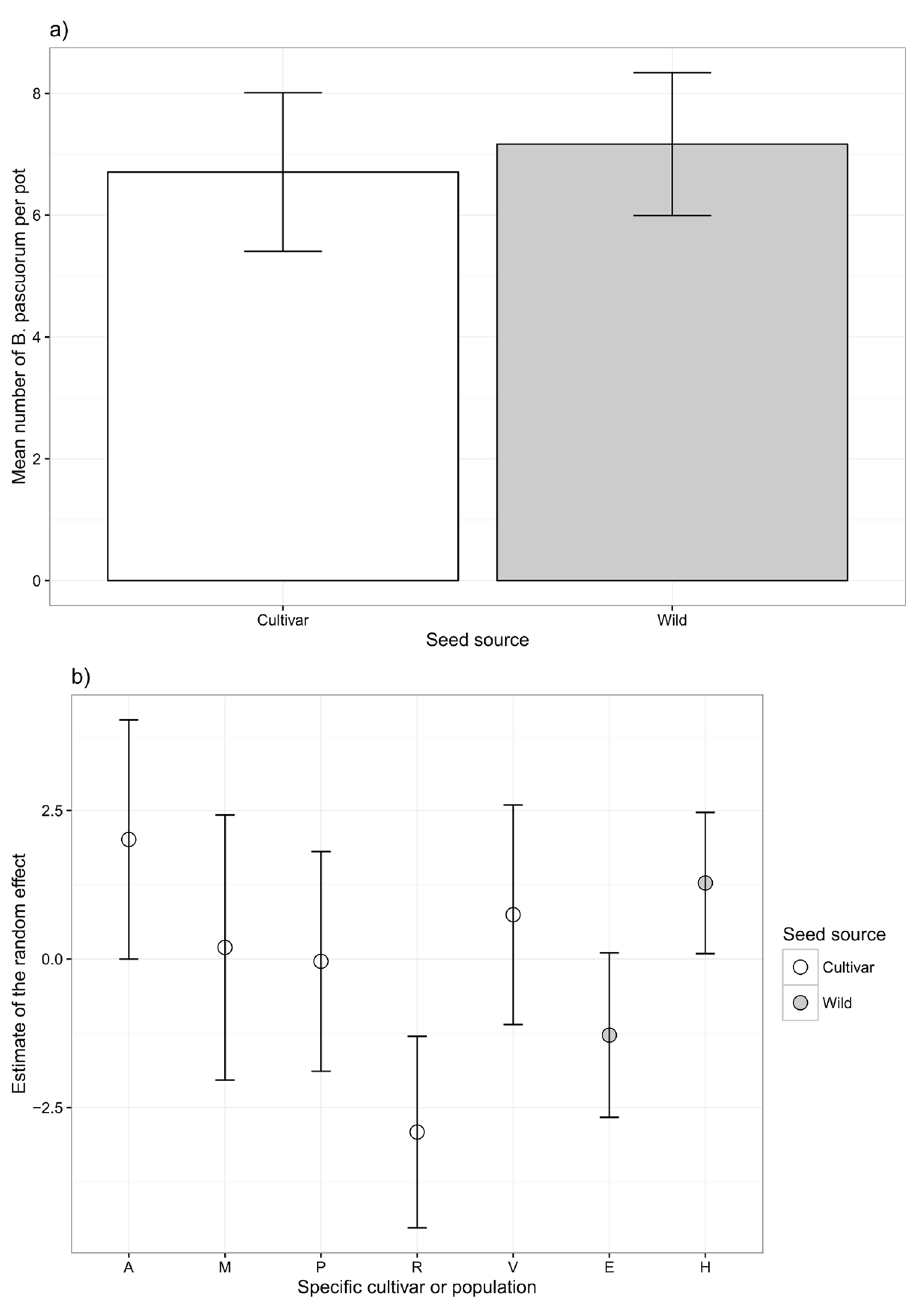
Fig 1. (a) Mean total abundance of Bombus pascuorum per pot for the cultivar (white) and wild (grey) treatments with 95% confidence intervals. (b) Estimate of the random effect for each specific cultivar (white) and wild population (grey) with 95% confidence